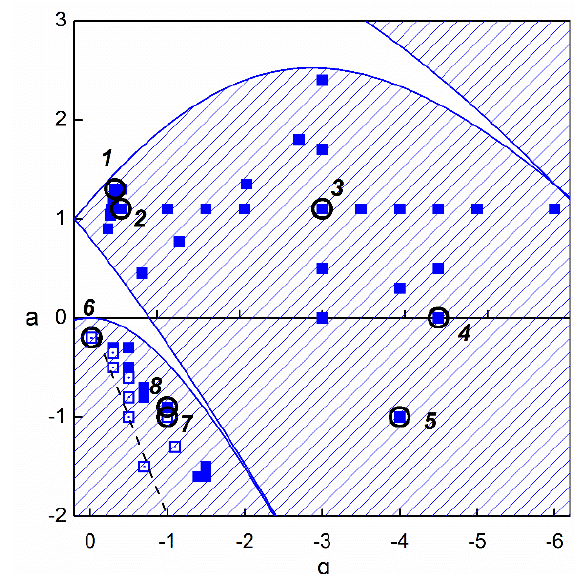
Figure 3. The points of (a, q) -diagram corresponding to the analyzed solutions of the Mathieu’s equation in the instability region (hatched area). Depending on the solution behavior, it may describe surface modes (filled squares) or be inappropriate because of the impossibility to fulfill the continuity condition (empty squares). The black numbered empty circles denote (a, q) -pairs for which the solution and its derivative are plotted below (Fig. 4). The dashed black line corresponds to a = − 2q (see explanation in the